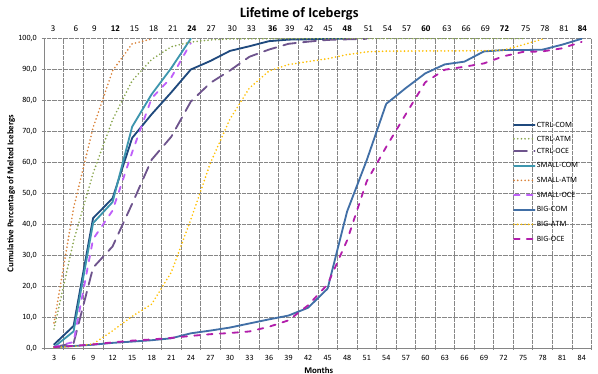
Figure 3. Cumulative iceberg melt distribution normalized to 100% as a function of time (months); x axis corresponds to months, y axis to cumulative